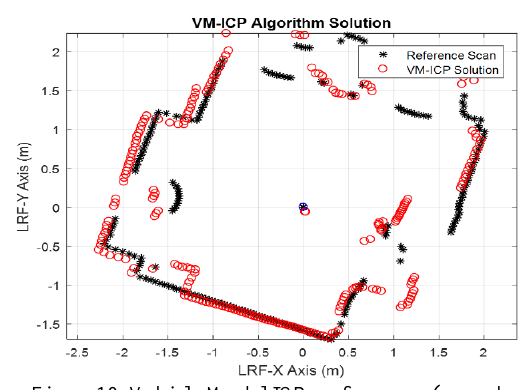
Figure 10. Vehicle-Model ICP performance (second